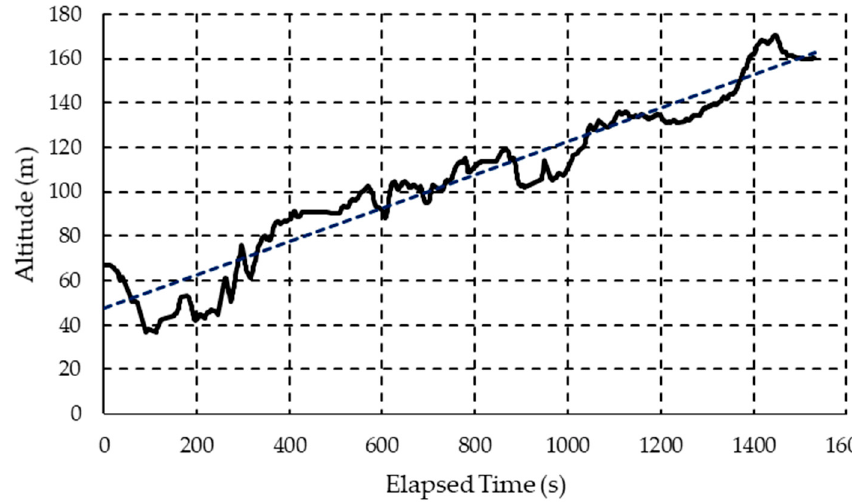
Figure 3. Altitude of the UPE route.